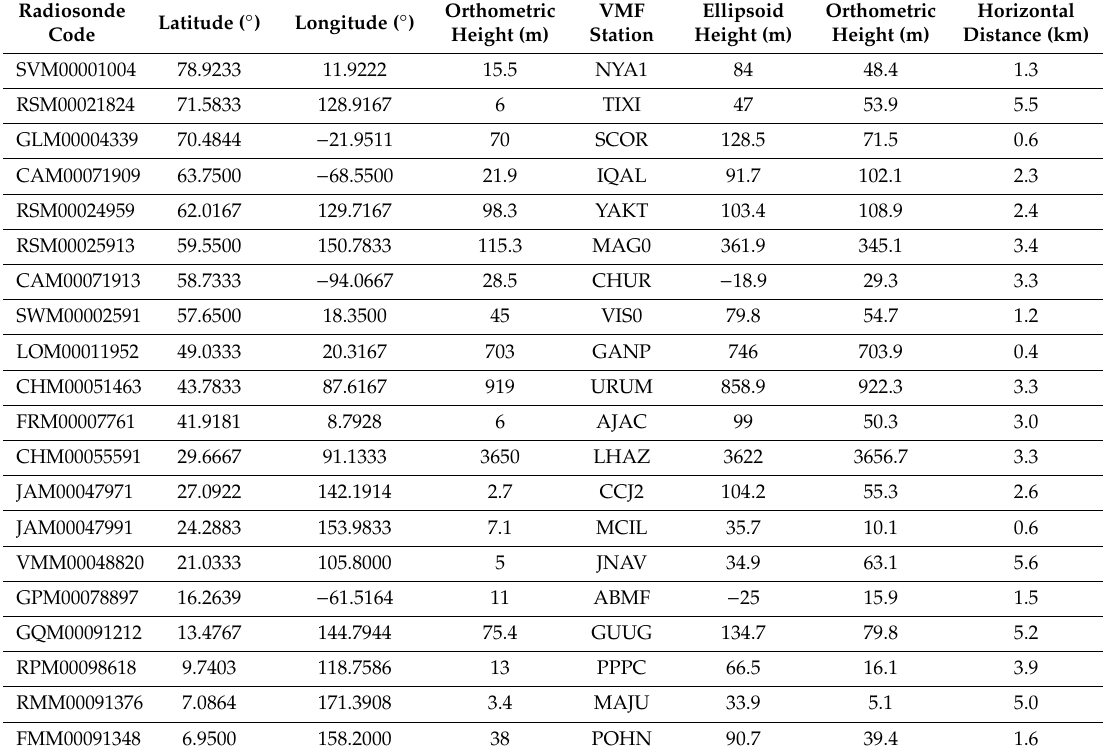
Figure 1. Global distribution of VMF1 / VMF3 radiosonde close sites used in this study. Table 2. Coordinates of radiosonde and VMF stations in Figure 1 and their horizontal distance.